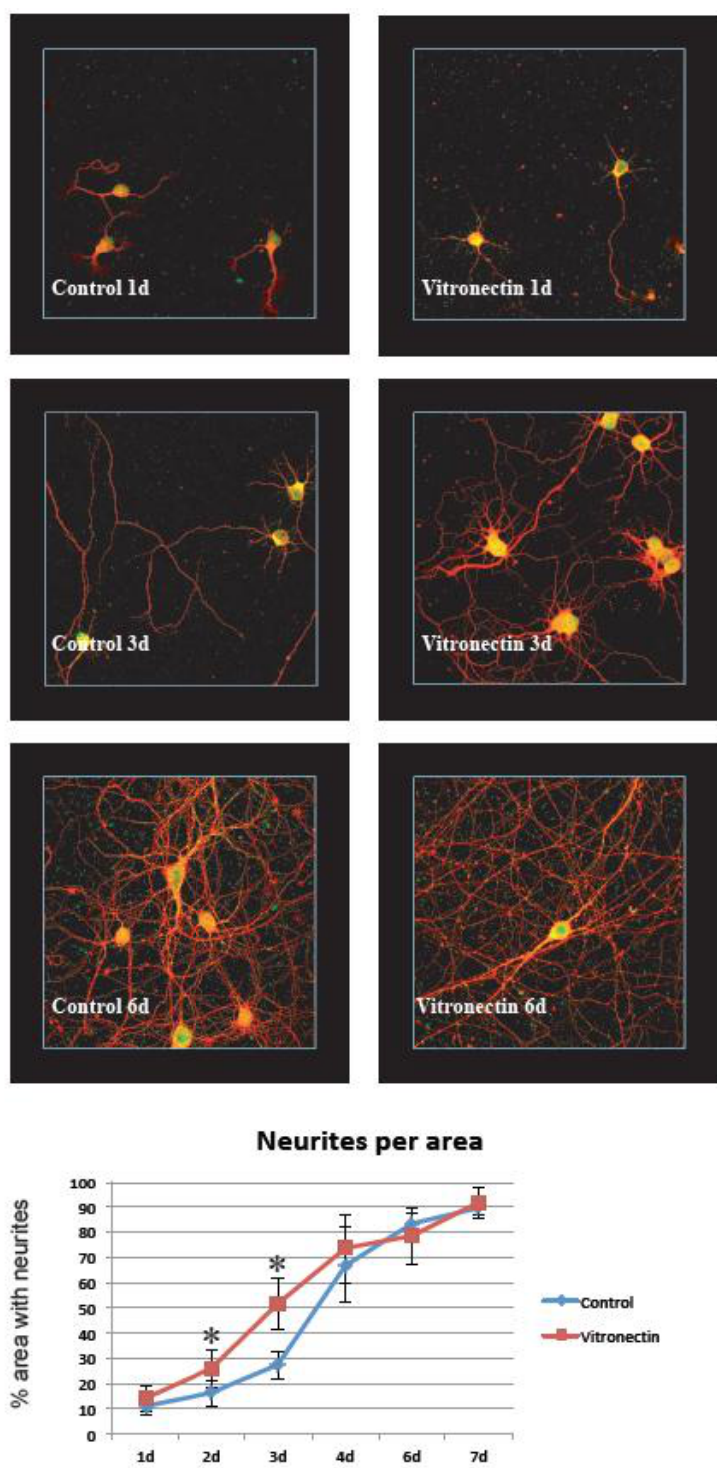
Figure 2. Hippocampal neurons grown on the vitronectin substrate showed an early increase in neurite growth compared with the controls. At 2 and 3 days there was significantly (*) more neurites per area (calculation of neurite density explained in Figure 1 and in the methods section) when neurons were grown on vitronectin compared to the controls ( n = 6 (6 wells per time point and treatment), two-way ANOVA, Bonferroni post hoc test, p < 0.05) (red = beta III tubulin, green/yellow = MAP2).